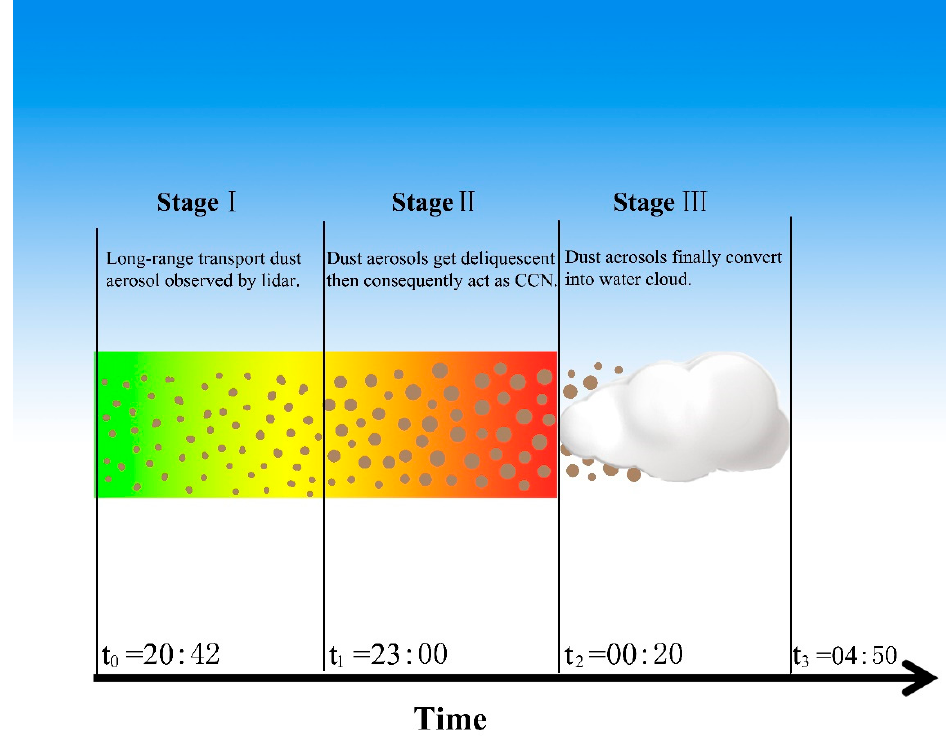
Figure 6. Schematic illustration of three stages of heterogeneous process, during which long-range transported dust aerosols are converted into water cloud under moist conditions in the atmosphere. Brown dots represent dust aerosols. The x-axis shows the evolution of the process estimated mainly from lidar measurements. Shadings show gradual change of water vapor at the altitude of the dust layer, and green and red colors represent low and high values of water vapor content, respectively.